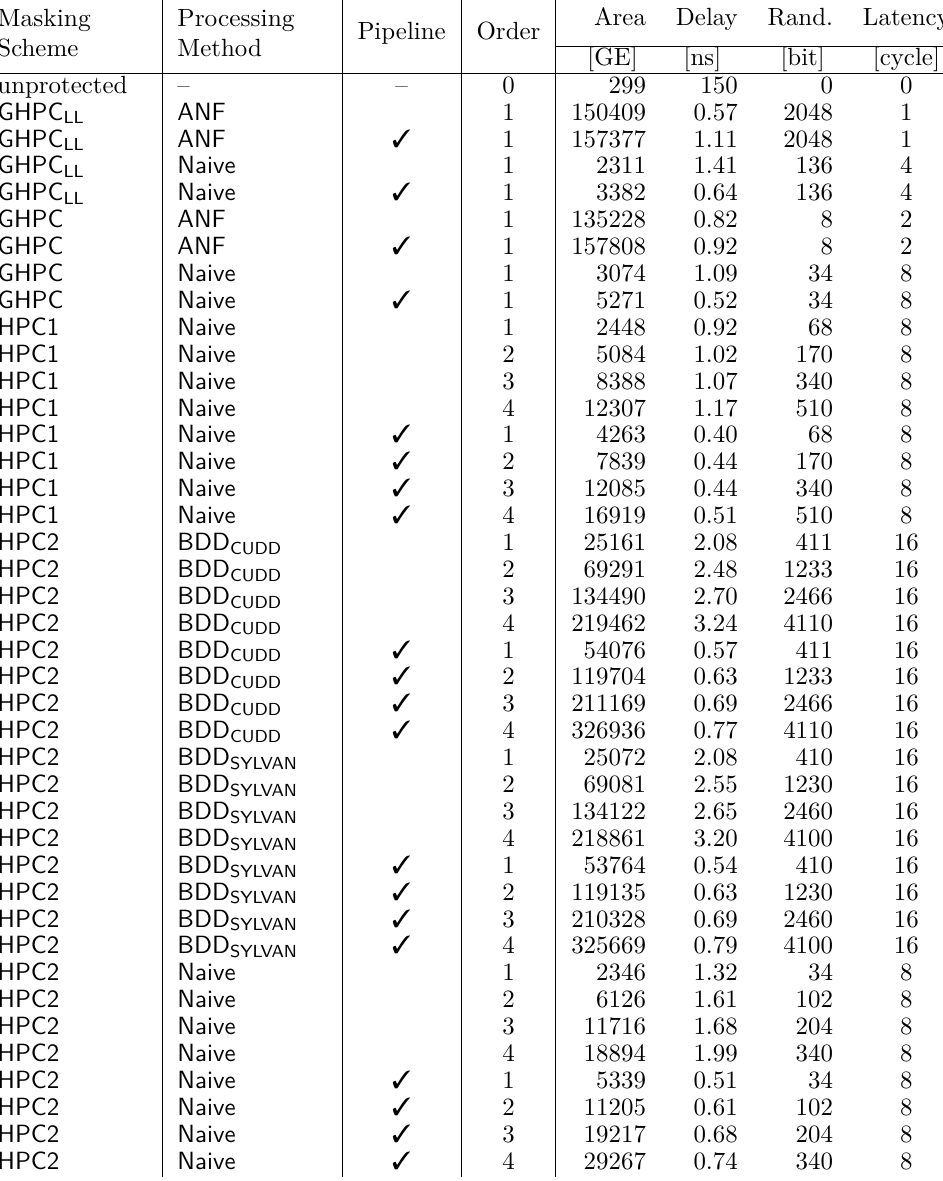
Table 7: Synthesis results, AES S-box optimized